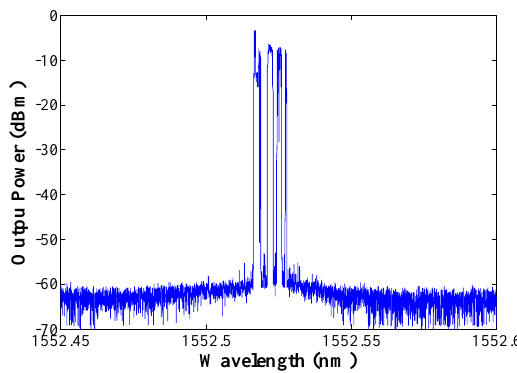
Figure 7. Hold trace of the laser emission. It exhibits a wavelength variation under 11 pm over 10 min when 2 m of M12 was used as unpumped EDF.